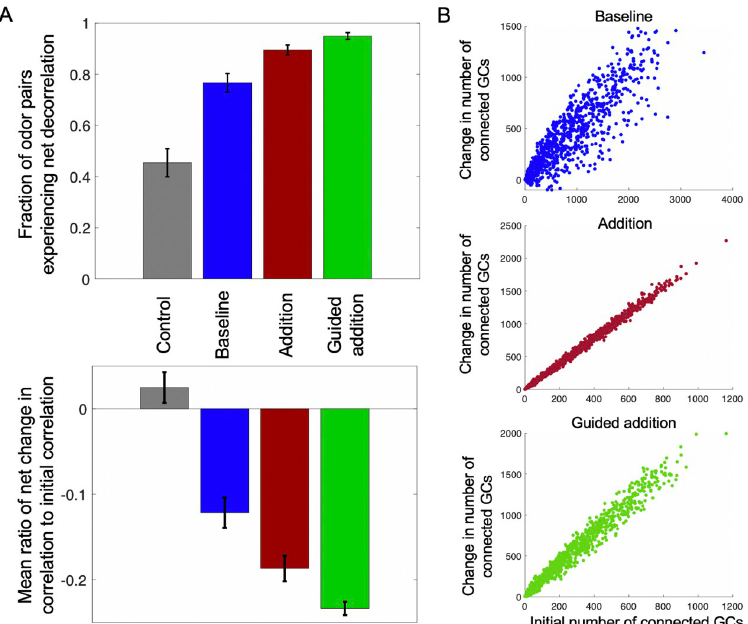
Fig 7. The effects of different modes of neurogenesis on OB structure and function. (A) Different modes of neurogenesis produce different levels of reduction in correlation between odor pairs. On average, the baseline mode (dark blue) produced a 12.16% relative reduction in odor pair correlation (SEM = 0.0177, bottom panel), and 76.7% of odor pairs experienced a net decorrelation (SEM = 0.0361, top panel). The addition mode (dark red) produced an average relative reduction of 18.7% (SEM = 0.0150, bottom panel), and 89.5% of odor pairs were decorrelated at the end of all rounds of neurogenesis (SEM = 0.0193, top panel). The guided addition mode (green) had the strongest effect, leading to an average relative reduction of 23.4% (SEM = 0.0078, bottom panel), with 94.9% of all odor pairs having a net decrease in correlation (SEM = 0.0130). Meanwhile, the control mode (gray) produced little change in the relative reduction (mean = 2.5%, SEM = 0.0180), with 45.4% of odor pairs experiencing net decorrelation (SEM = 0.0548), about what one would expect from chance. Bars indicate the standard error of the mean (SEM). Each mode’s means were averaged from the means of N = 10 trials. (B) Use of a localization rule reduces anatomic constraints on MC connectivity with new GCs. Each panel represents the relationship between a MC’s initial number of connected GCs with the ultimate change in the number of connected GCs following all rounds of neurogenesis.